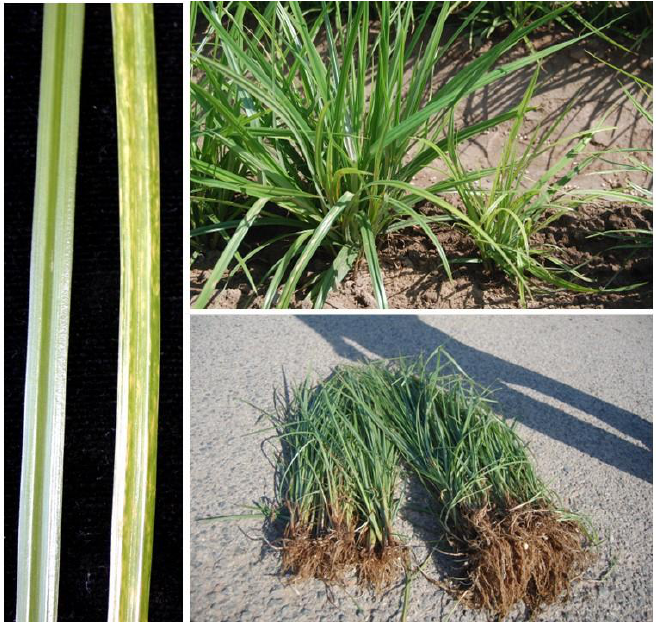
Figure 1. Symptoms found in some C. esculentus plants: leaves with yellowing or chlorosis following a mosaic pattern in streaks and stunting in the aerial parts and roots with lower tuber production.